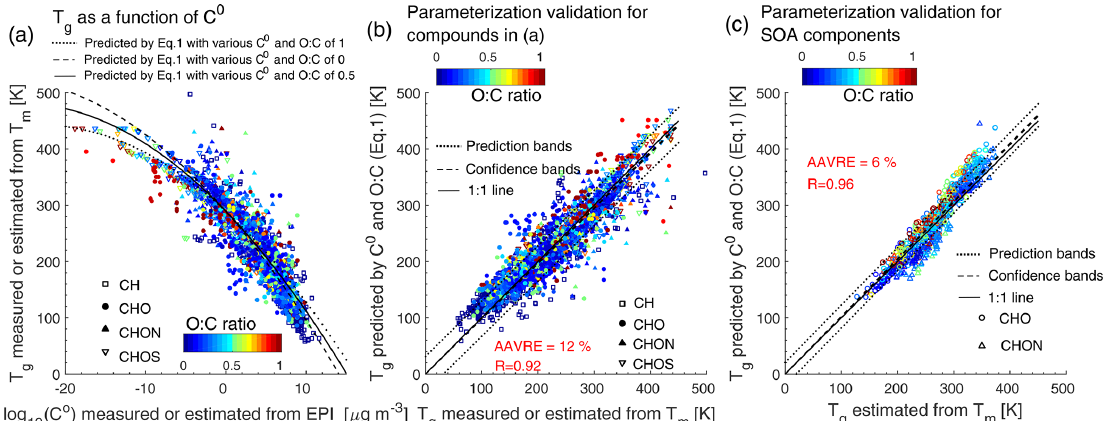
Figure 1. (a) T g of organic compounds in the training dataset plotted against C 0 . The lines show the predictions of T g (Eq. 1) by C 0 and the O : C ratios of 0 (dashed), 0.5 (solid), and 1 (dotted). (b) Predicted T g by C 0 and the O : C ratio (Eq. 1) for compounds shown in (a) compared to measured or otherwise estimated T g from T m . (c) Predicted T g for SOA components (Shiraiwa et al., 2014) using Eq. (1) plotted against estimated T g from T m with the Boyer–Kauzmann rule. The correlation coefficient ( R ) and the average absolute value of the relative error (AAVRE) are shown. In (b) and (c) the dashed and dotted lines show 68% confidence and prediction bands,